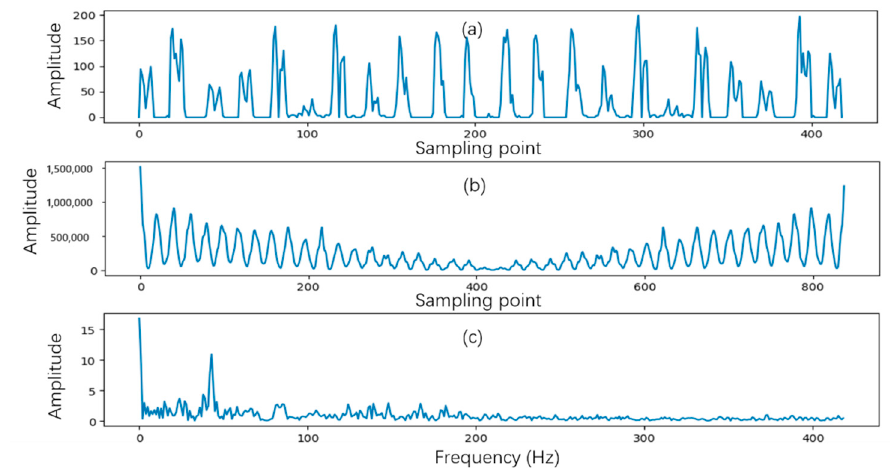
Figure 7. Extracting the image period from the ROI. ( a ) Statistical waveform; ( b ) self-correlation operation result; ( c ) spectrogram.